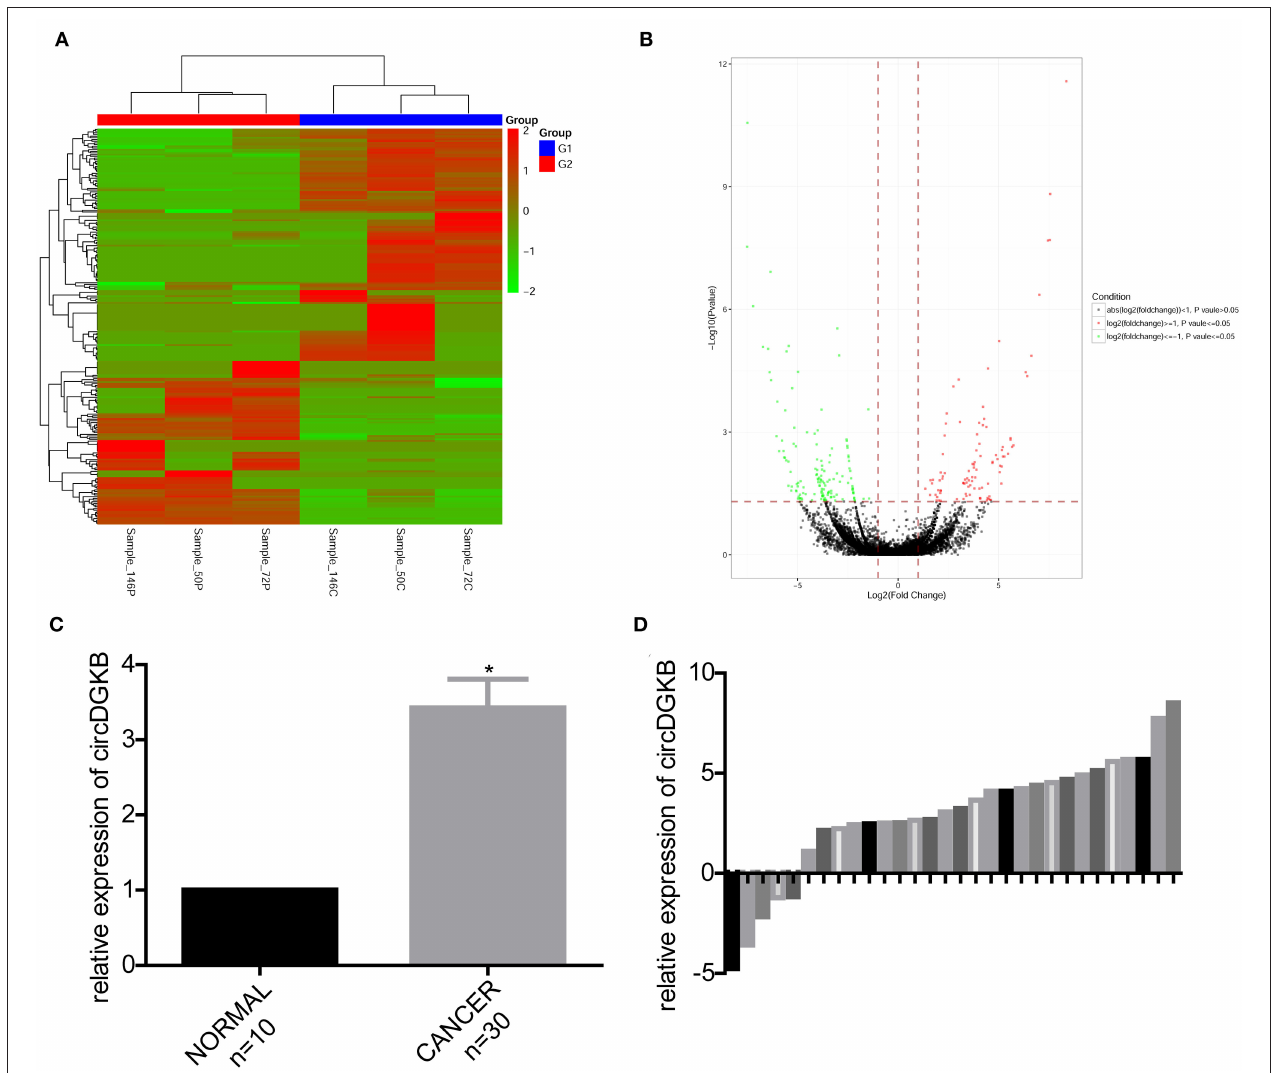
FIGURE 1 | CircDGKB was overexpressed in NB specimens. (A) Heat map of genes in 3 NB tissue specimens and 3 human normal dorsal root ganglia. Red represented the upregulated genes while green were the downregulated genes. (B) Volcano plot of genes in 3 NB tissues and 3 human normal dorsal root ganglia. Red represented the upregulated genes while green were the downregulated genes. (C) QRT-PCR was taken to evaluate the expression of circDGKB in 30 NB tissue specimens and 10 human normal dorsal root ganglia, * P < 0.05. (D) QRT-PCR was taken to detect the relative expression levels of circDGKB in 30 NB tissue specimens to 10 normal dorsal root